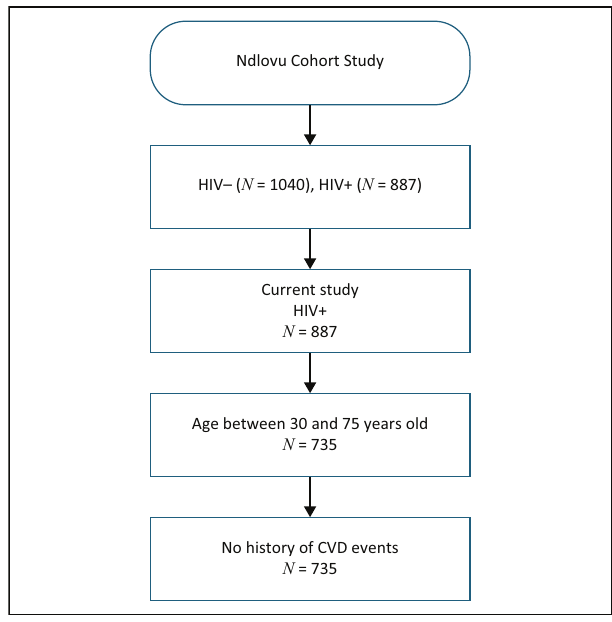
FIGURE 1: Flow chart of